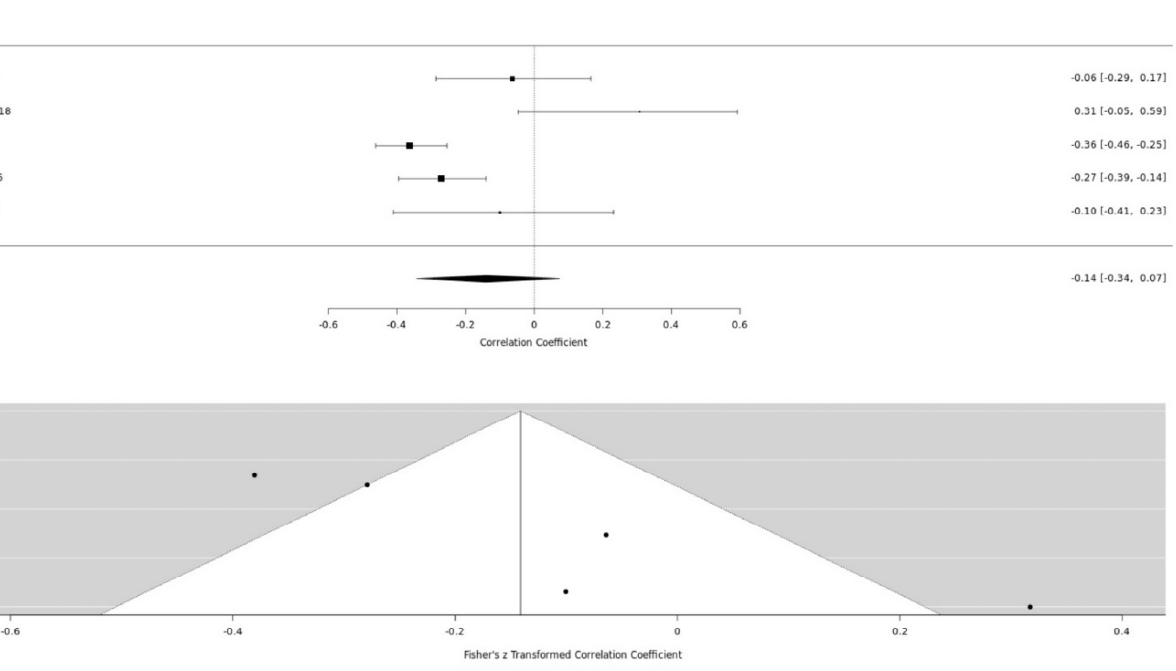
12th month) [35]. No correlation between the two was noted at any time-point (MANOVA test, p =